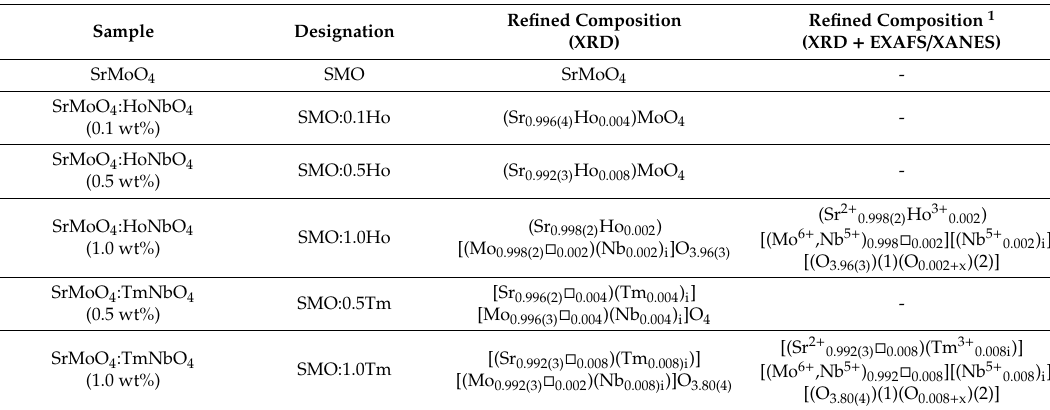
Table 4. Refined compositions of SrMoO 4 , SrMoO 4 :Ho, SrMoO 4 :Tm crystals according to